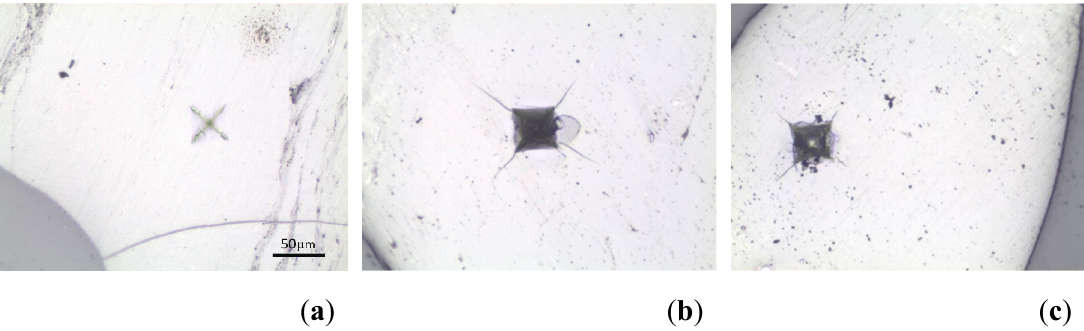
Figure 6. Photographs after the microhardness analysis, showing the nature of cracks and other damage caused by the Vickers indenter being pressed into the analysed material. ( a ) R 0 = 0.8%; ( b ) R 0 = 1.1%; ( c ) R 0 = 2%. Reflected light.